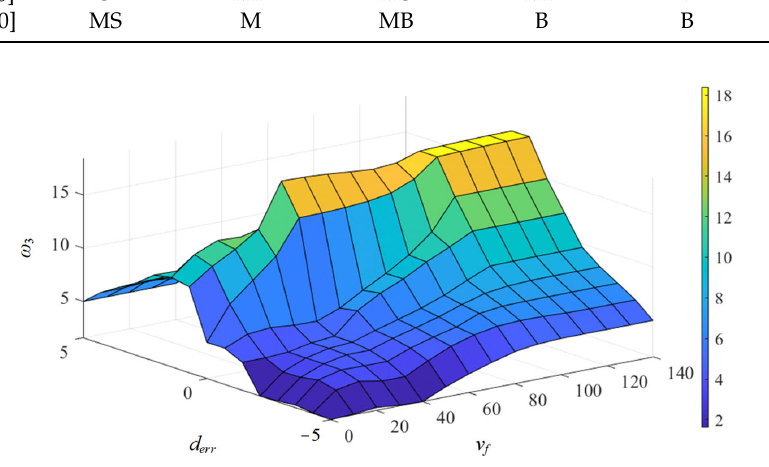
Figure 7. Membership function: ( a ) v f , ( b ) d err , ( c ) ω 3 .